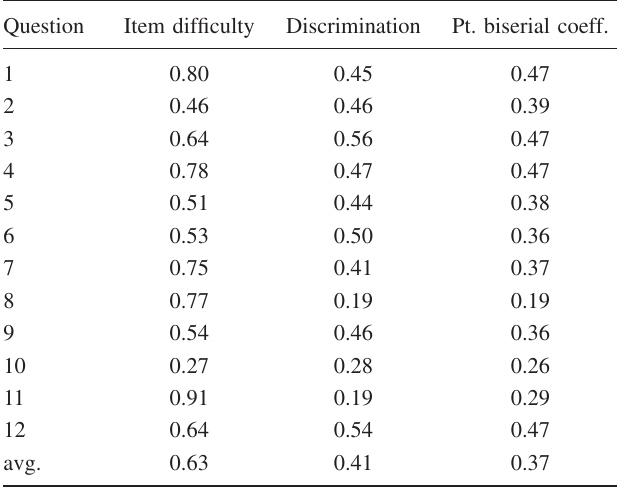
TABLE V. Item statistics for Version 2.0 questions given on posttest to modern physics students. N =370.